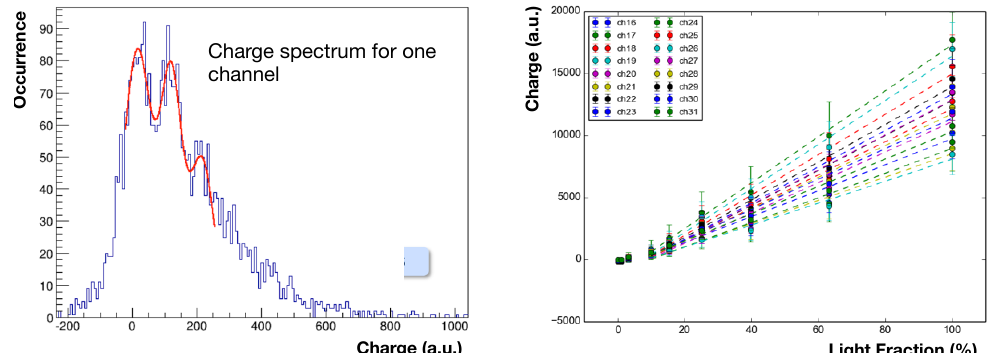
Figure 3. (a) Integrated signal over 16 ns of one channel with TARGET7. The red lines represent the gaussian fit used to find the peaks. (b) Average value of the charge distribution as function of the light intensity for 16 channels of one TARGET